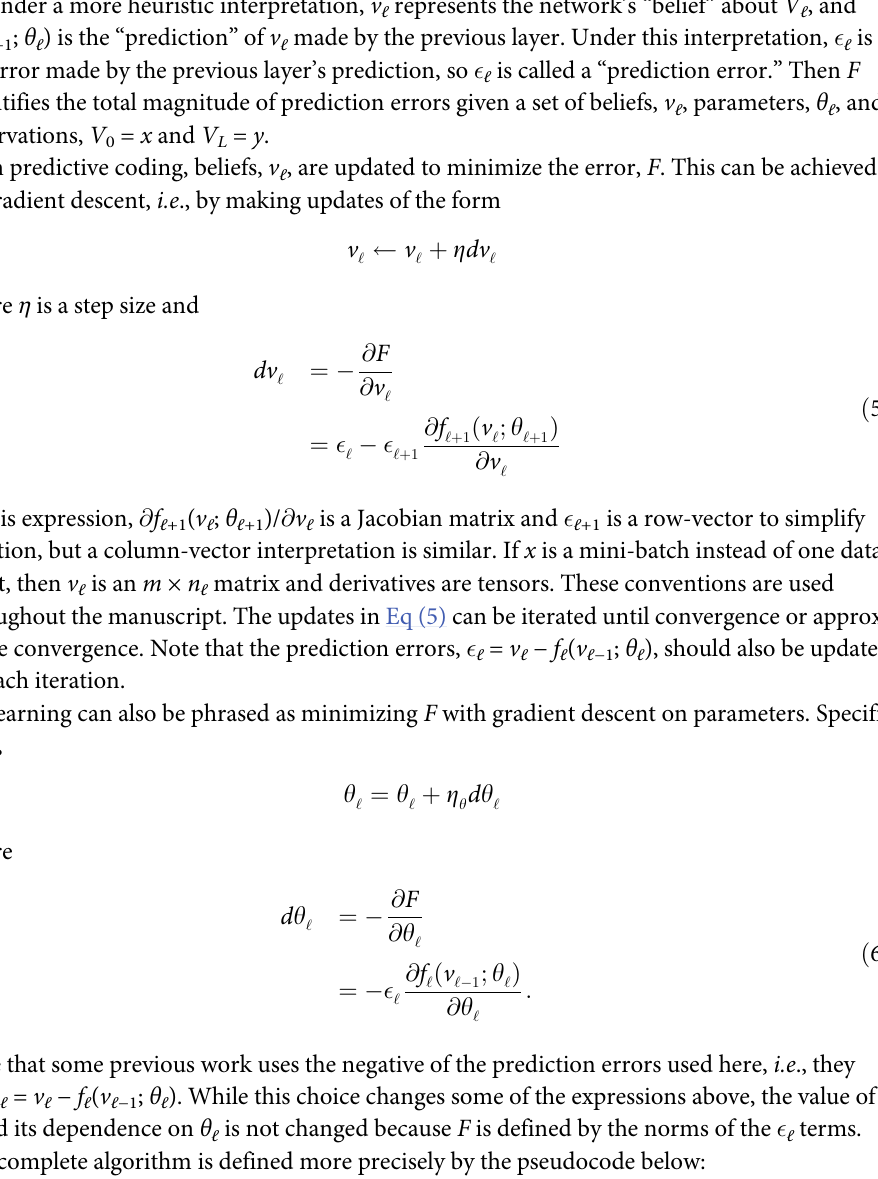
Algorithm 2 A direct interpretation of predictive